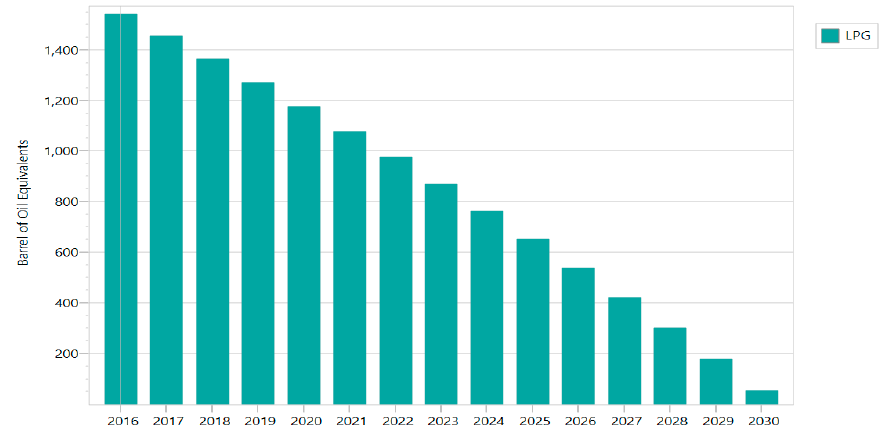
Energies 2020 , 13 , x FOR PEER REVIEW Figure 16. LPG consumption for the stoves plus LPG scenario. Rural residential area without access to electricity. to electricity.